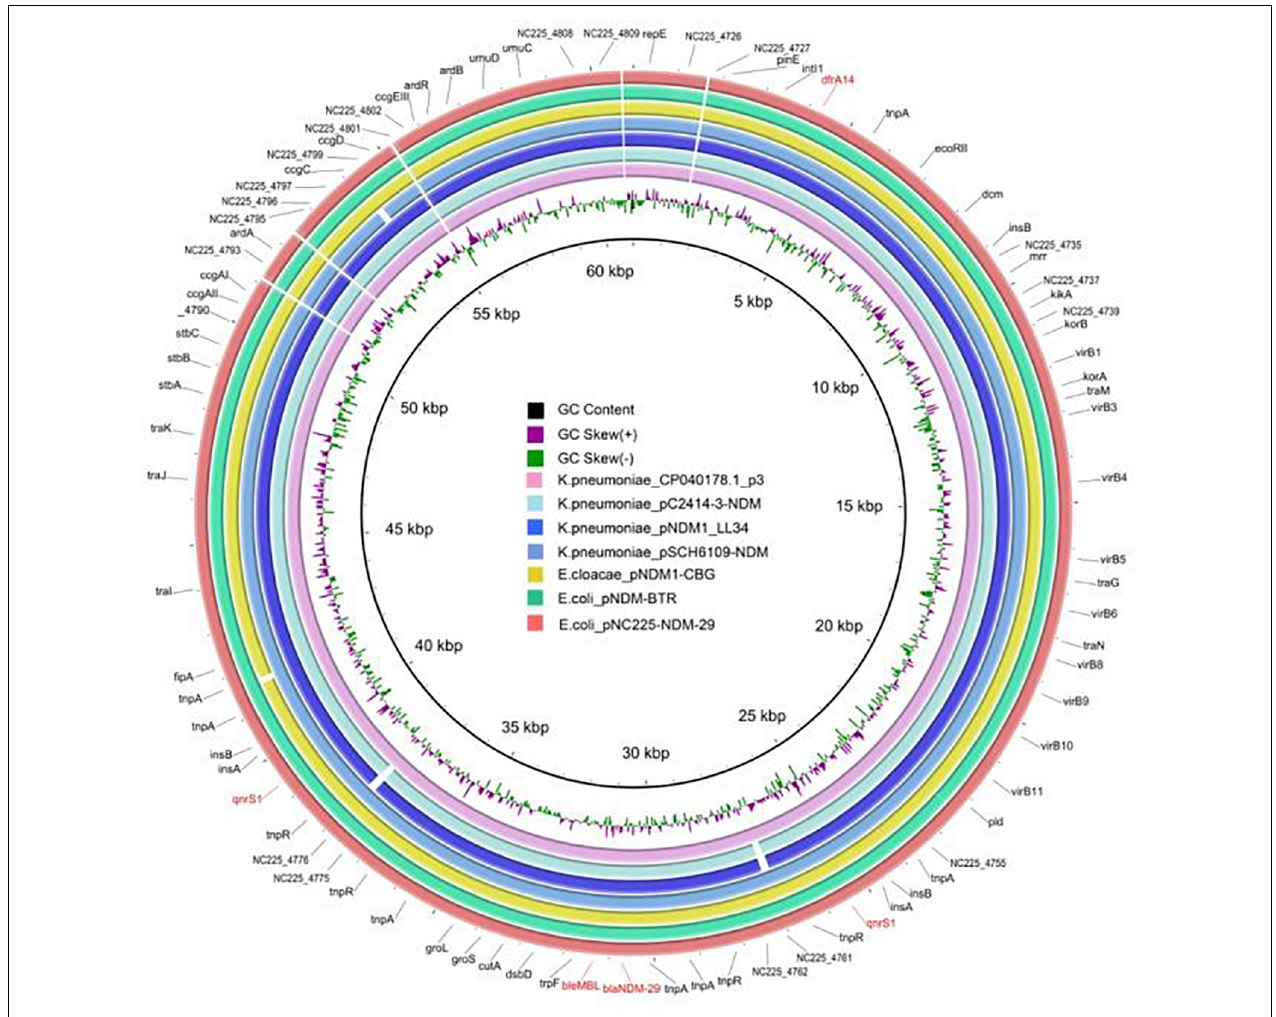
FIGURE 5 | Genetic structure of pNC225-NDM-29 and six bla NDM − 1 -harboring plasmids (pSCH6109-NDM, pNDM1_LL34, pC2414-3-NDM, and CP040178.1_p3 from Klebsiella pneumoniae ; pNDM1-CBG from Enterobacter cloacae ; and pNDM-BTR from Escherichia coli ). Alignments of resemble plasmids are shown as concentric rings. The outermost shows the main coding genes of pNC225-NDM-29. Antimicrobial-resistance genes are highlighted in